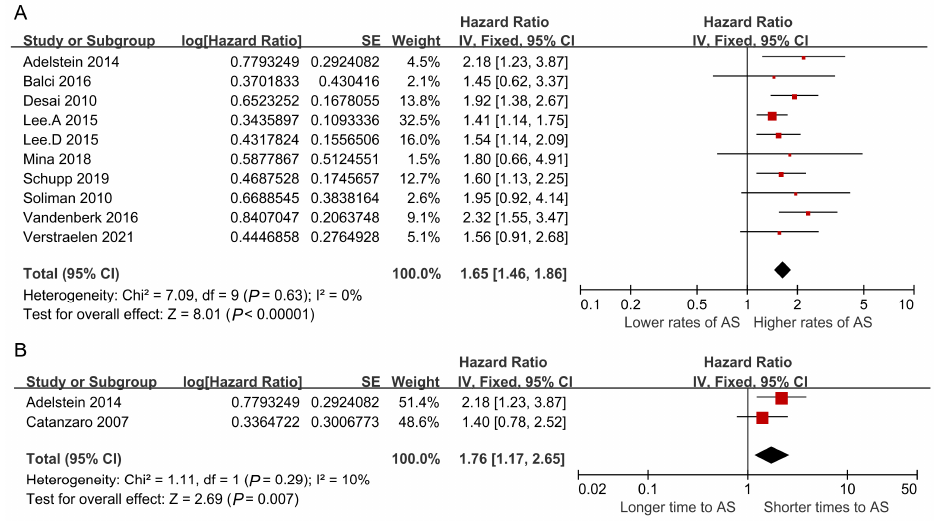
Figure 2. Pooled risk of shocks. Given the low heterogeneity, a fixed effects model was used. ( A ) Forest plot of the association between digitalis and risk of appropriate shocks. ( B ) Forest plot assessing the time to first appropriate shock in ICD or CRT-D recipients administered digitalis